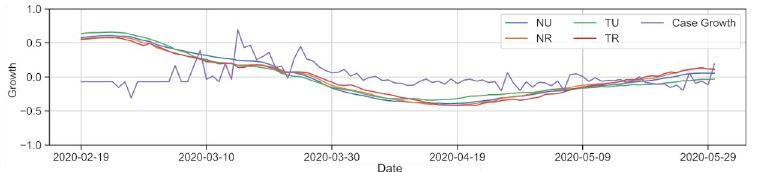
Fig 8. Categorical mobility averages and case growth arrays for all SoCal counties excluding LA and OR. Cluster categories are determined with the 50% scheme. These arrays cover 102 days in the first wave of cases, February 19— May 31. All cluster mobilities share similar seasonality, but our subsequent analysis finds that tribal mobility correlation is consistently higher with respect to case growth in the surrounding